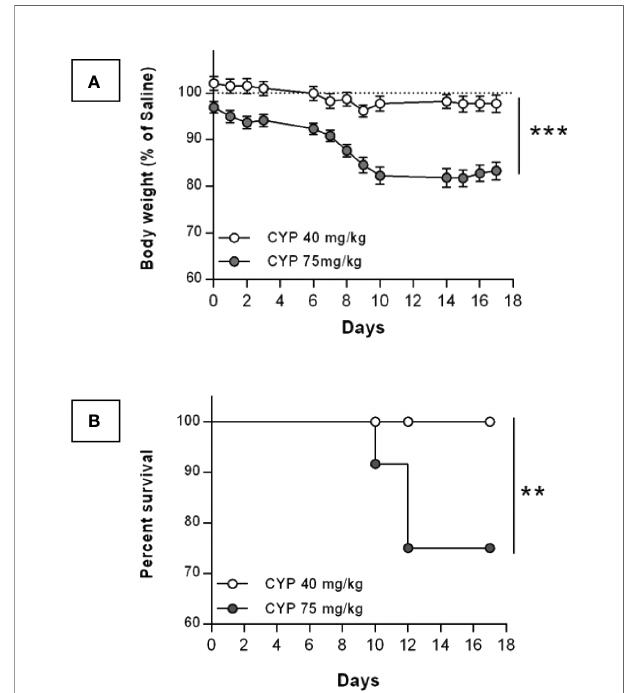
FIGURE 2 | Change in body weight and survival after chronic injection of CYP at either 40 or 75 mg/kg dose. Rats received three intraperitoneal injections of saline (n = 12) at 5 ml/kg or CYP at either 40 (n = 24) or 75 (n = 12) mg/kg, on days 0, 3, and 6. (A) Body weight of CYP-injected rats were recorded over 17 days. Results were expressed as percentage of body weight of saline rats recorded at each time-point. Data represent mean values ± SEM. ***p < 0.001 (two-way RM ANOVA). (B) Kaplan-Meyer survival curves for rats chronically treated with either 40 or 75 mg/kg dose of CYP. **p = 0.0089 (Log-rank